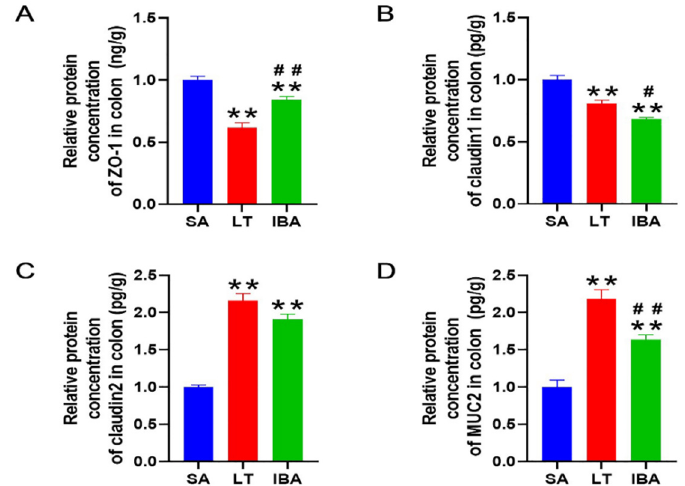
Figure 10. ELISA assay results for ( A ) protein concentrations of ZO-1, ( B ) protein concentrations of claudin-1, ( C ) protein concentrations of claudin-2, ( D ) protein concentrations of MUC2. SA, summer active; LT, late torpor; IBA, interbout arousal. Mean ± SEM. n = 6. Compared with SA group, ** p < 0.01. Compared with LT group, # p < 0.05, ## p < 0.01.